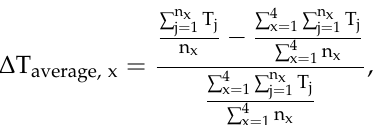
Figure 9. Heat pipe position 1–4.